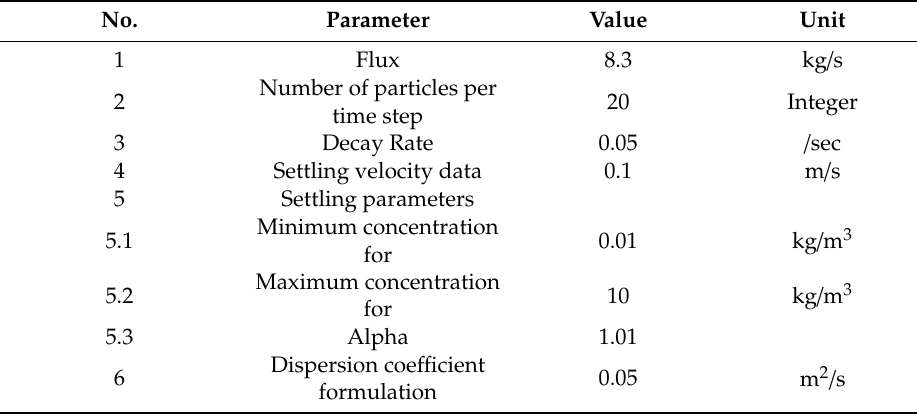
Table 3. The parameters of particle tracking (PT) in 2D